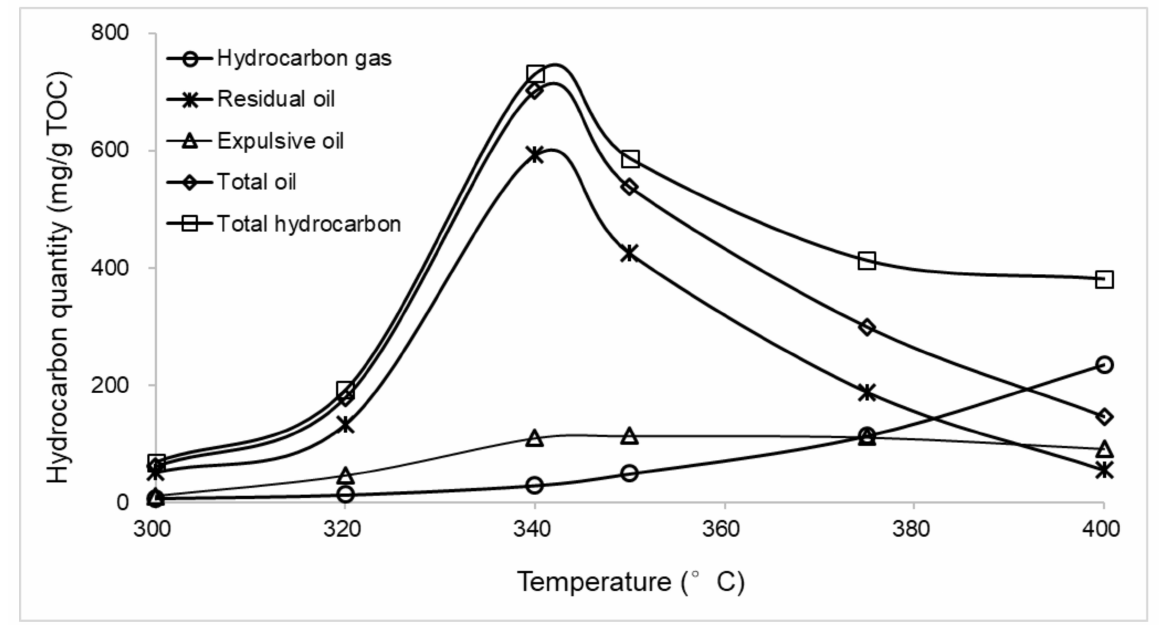
Figure 3. Yields from thermal simulation experiments of the Tasmanite oil shale sample